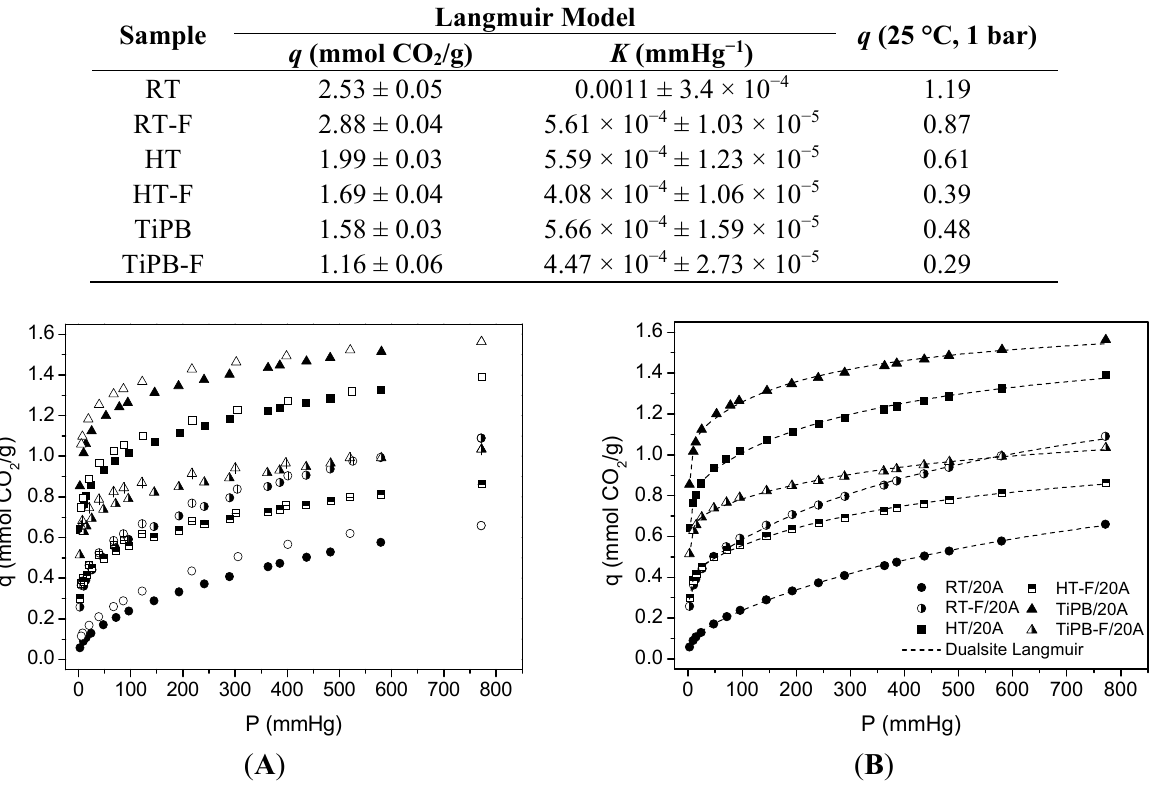
Figure 5. ( A ) CO 2 isotherms at 25 °C on 3-aminopropyltriethoxysilane (APTES)-grafted silicas Adsorption data are the filled symbols and desorption data are the empty symbols; ( B ) dotted lines are fits from de Dualsite Langmuir model using adsorption